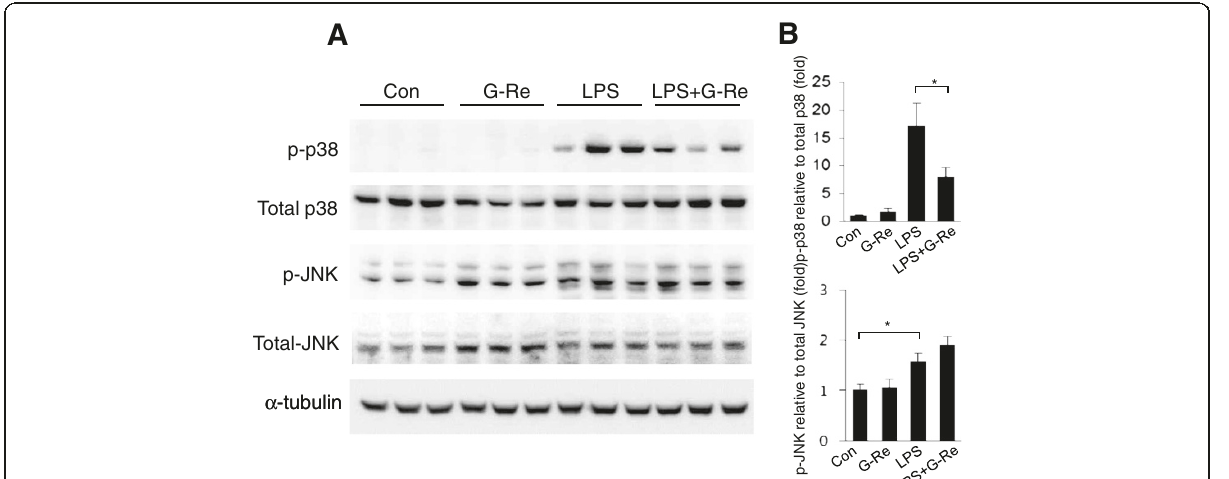
Figure 2 Ginsenoside-Re inhibits LPS-induced phosphorylation of p38MAPK in BV2 microglial cells. ( A ) The level of phosphorylated p38MAPK was highly increased by LPS alone and was diminished by G-Re. BV2 cells were pretreated with 2 μ g/ml G-Re for 1 h and then stimulated with 1 μ g/ml LPS for 15 min in the presence or absence of 2 μ g/ml G-Re. Western blots were performed with specific antibodies, including the phosphorylated form of p38 and JNK. Total p38, JNK and α -tubulin were used as loading controls for the cell lysates. The values shown are the mean ± S.E.M. of data obtained from three independent experiments. * p < 0.05, ** p < 0.01. ( B ) Quantification of A. No differences were found with the G-Re alone treatments. * p < 0.05, ** p <